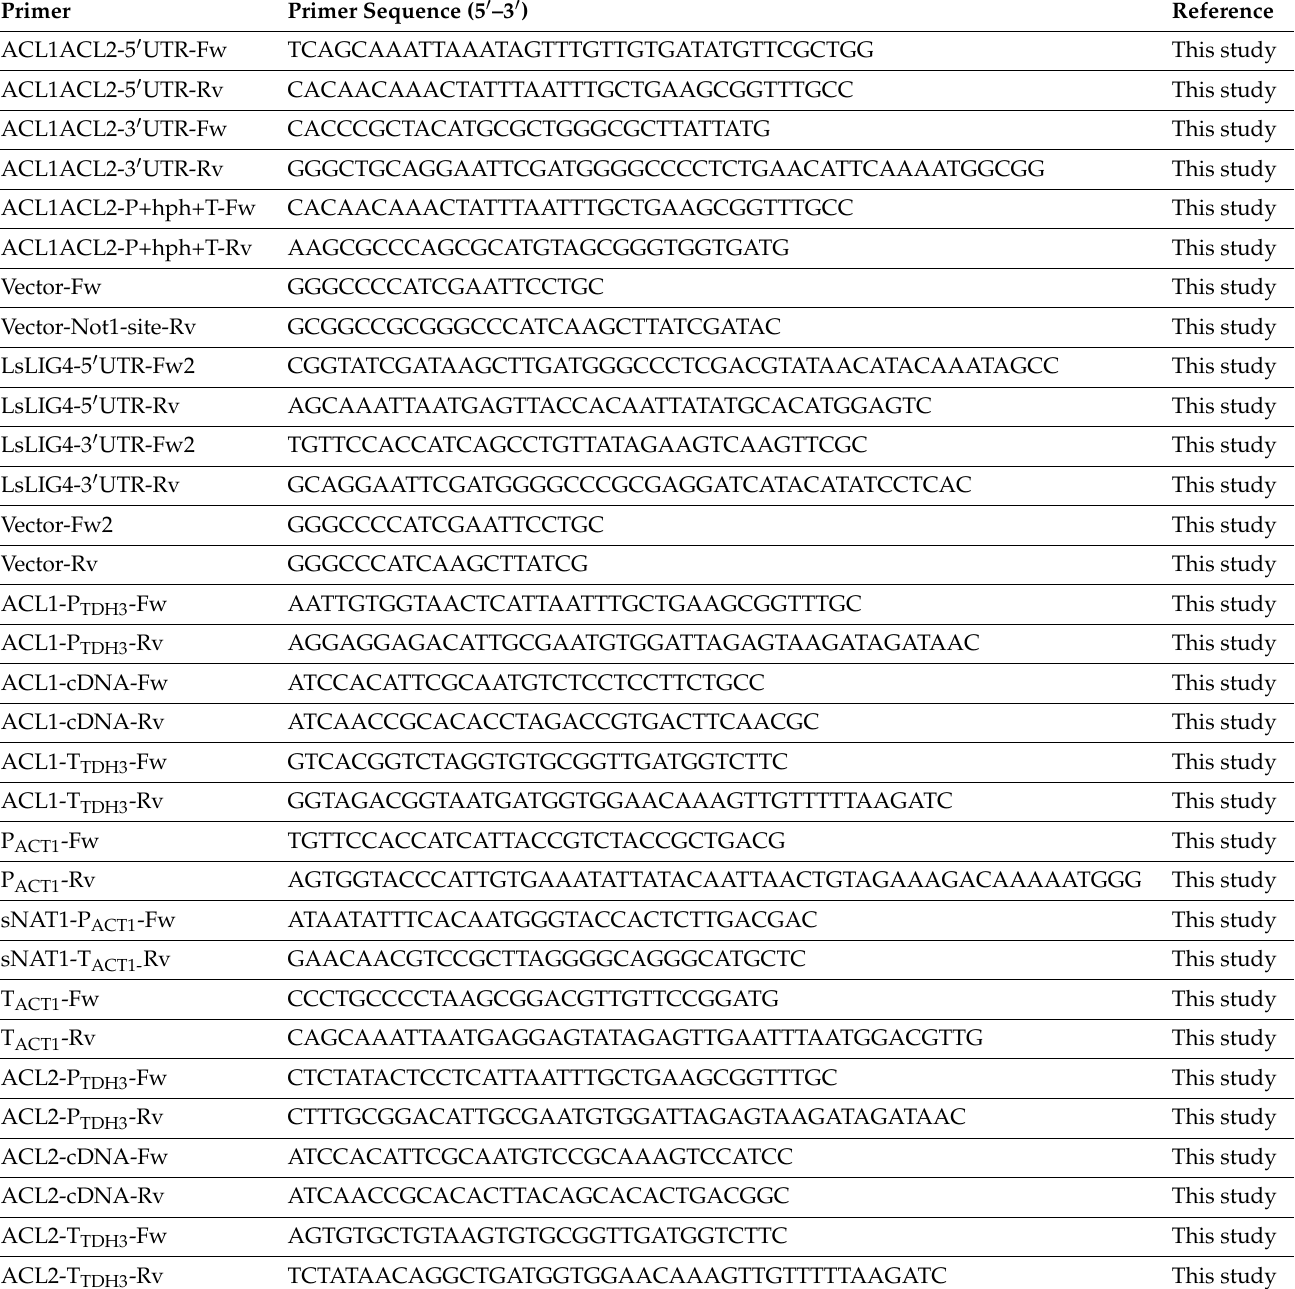
Table 1. List of primers and primer sequences used for plasmid construction in this study. Primer Primer Sequence (5 (cid:48) –3 (cid:48)